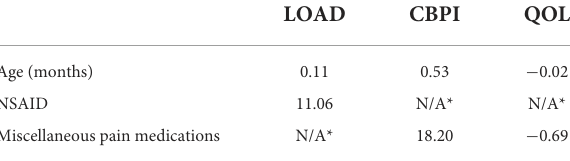
TABLE 5 Regression analysis